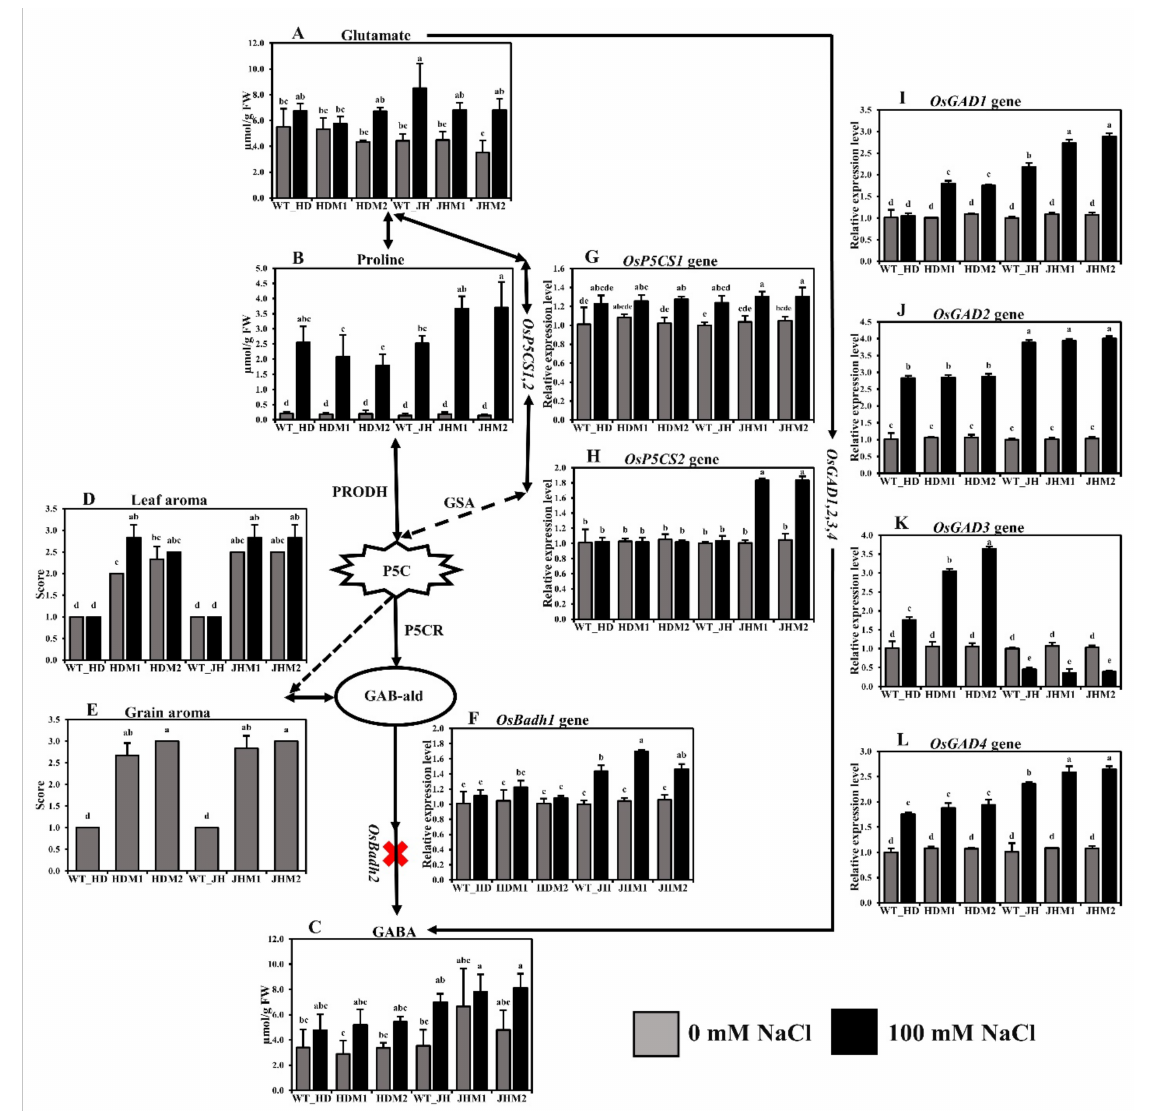
Figure 4. Biosynthesis pathway of rice aroma with gene expression and free amino acid content: ( A ) glutamate content; ( B ) proline content; ( C ) γ -aminobutyric acid (GABA) content; ( D ) leaf aroma; ( E ) grain aroma. The aroma score was calculated based on the 1–4 scale, where 1—no aroma; 2—mild aroma; 3—moderate aroma; 4—excellent aroma; ( F ) relative expression of OsBadh1 ; ( G ) relative expression of OsP5CS1 ; ( H ) relative expression of OsP5CS2 ; ( I ) relative expression of OsGAD1 ; ( J ) relative expression of OsGAD2 ; ( K ) relative expression of OsGAD3 ; ( L ) relative expression of OsGAD4 . The rice cultivars Huaidao#5 (WT_HD) and Jiahua#1 (WT_JH) were the experimental control (nontreated) for their respective mutant lines, and OsActin was an internal reference in the 2 − ∆∆ CT method. Data are shown as the mean and standard deviation of 3 biological repli- cates with 3 technical replications. Data with different letters (a, b, c, etc.) represent significance at a 0.05 level, using the Tukey Method. PRODH, proline dehydrogenase; GSA, gamma glu- tamyl semialdehyde; P5C, ∆ 1 -pyrroline-5-carboxylate; P5CR, ∆ 1 -pyrroline-5-carboxylate reductase; GAB-ald, γ -aminobutyraldehyde; red cross sign (X), knockout mutations in OsBadh2 gene. The grain aroma score increased in the mutant lines compared to their wild